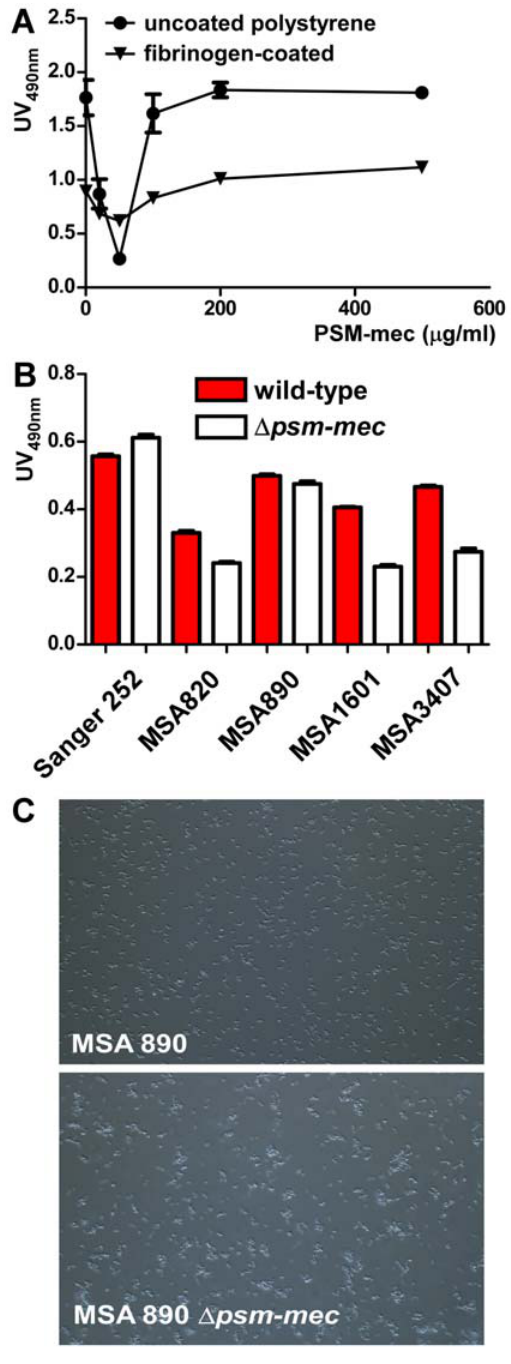
Figure 8. Influence of PSM-mec on biofilm formation and intercellular aggregation. (A) Impact of increasing concentrations of synthetic PSM-mec on biofilm formation using uncoated and fibrino- gen-precoated polystyrene microtiter plates. PSM-negative S. aureus SA113 was used as indicator biofilm-forming strain. (B) Biofilm formation by S. aureus PSM-mec producers in comparison to isogenic psm-mec deletion mutants. (C) Aggregation phenotype of S. aureus MSA890 and isogenic psm-mec deletion mutant during mid-exponential growth phase (3 h) in shaken TSB flasks. Note that these are the same conditions as used to inoculate animals, in which owing to the aggregation phenotype, qRT-PCR and OD rather than CFU measure- ments were used to guarantee equal inocula. Differences in aggrega- tion of the other isogenic strain pairs were similar or less pronounced.